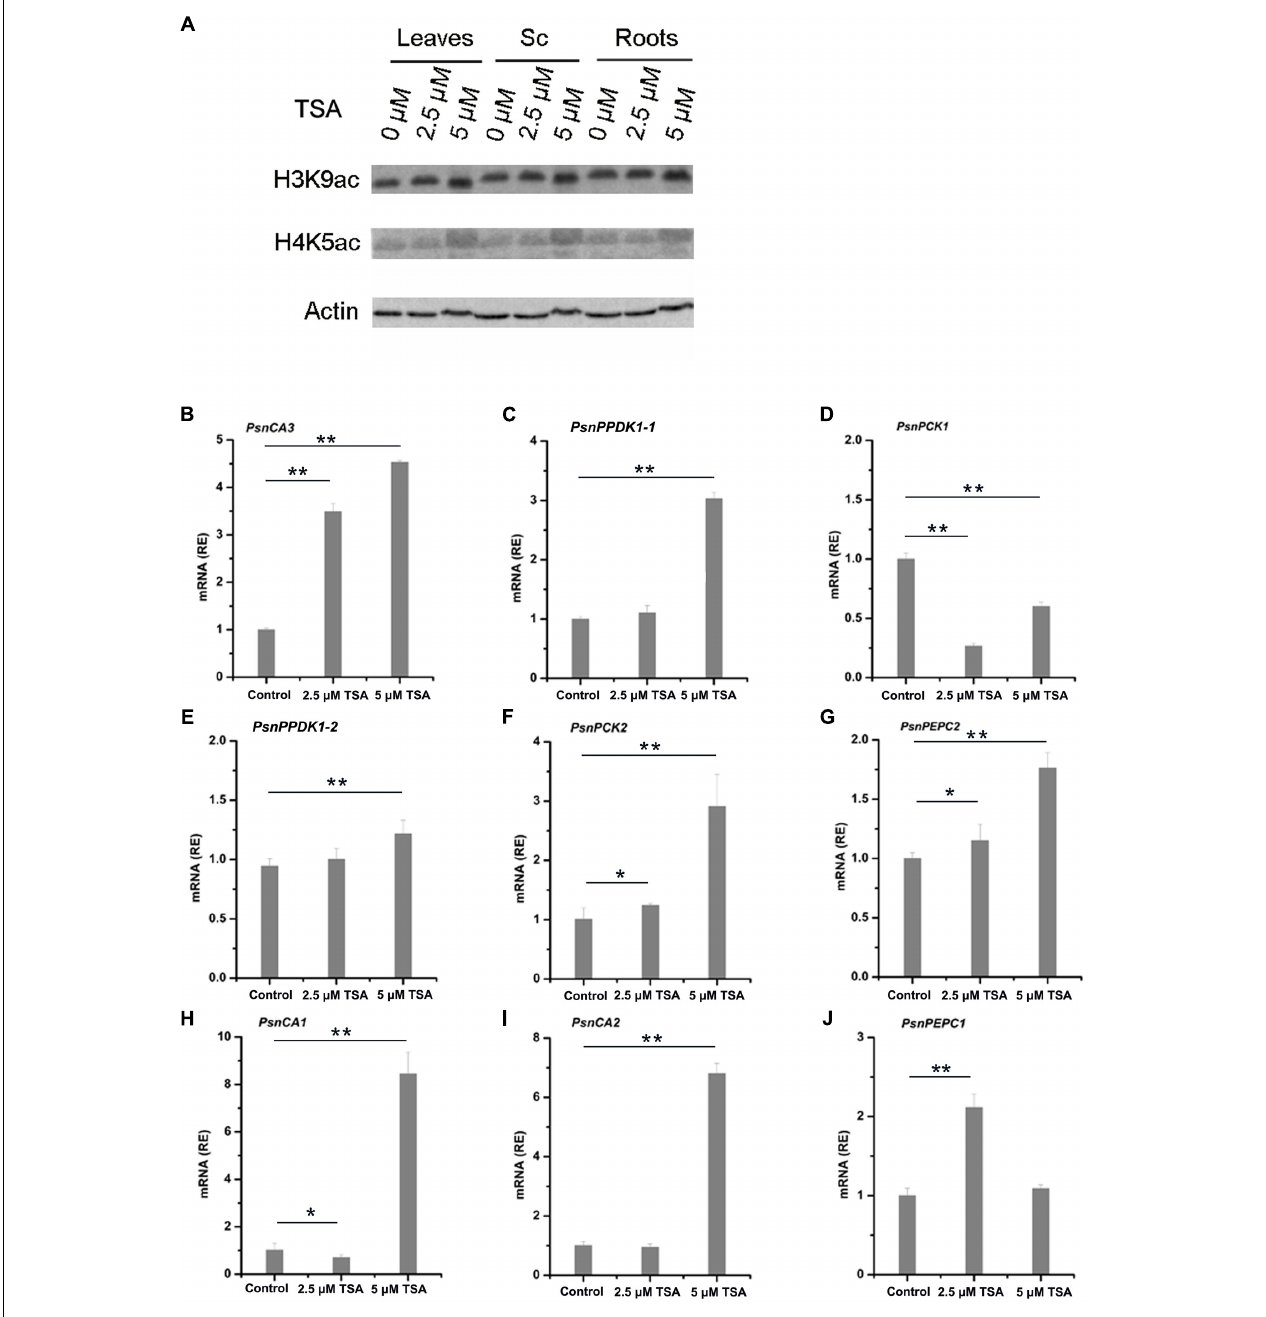
FIGURE 5 | TSA affects H3K9ac and H4K5ac protein levels and mRNA levels of poplar homologs of C 4 photosynthetic enzyme genes. (A) Western blot analysis of H3K9ac and H4K5ac protein levels in leaves (L), stem chlorenchyma (Sc), and roots (R) of poplar treated with TSA for 2 days. ACTIN was used as a control for equal loading. Expression of the PsnCA3 , PsnPPDK1-1 , and PsnPCK1 genes in leaves (B–D) , the PsnPPDK1-2 , PsnPCK2 , and PsnPEPC2 genes in Sc (E–G) , and the PsnCA1 , PsnCA2 , and PsnPEPC1 genes in roots (H–J) of poplar treated with TSA for 2 days. All expression levels were normalized to PsnACTIN2 expression. Values are means from three independent experiments. Bars indicate SE. Asterisks indicated significantly different means ( ∗ p < 0.05; ∗∗ p < 0.005) as determined with a t -test.